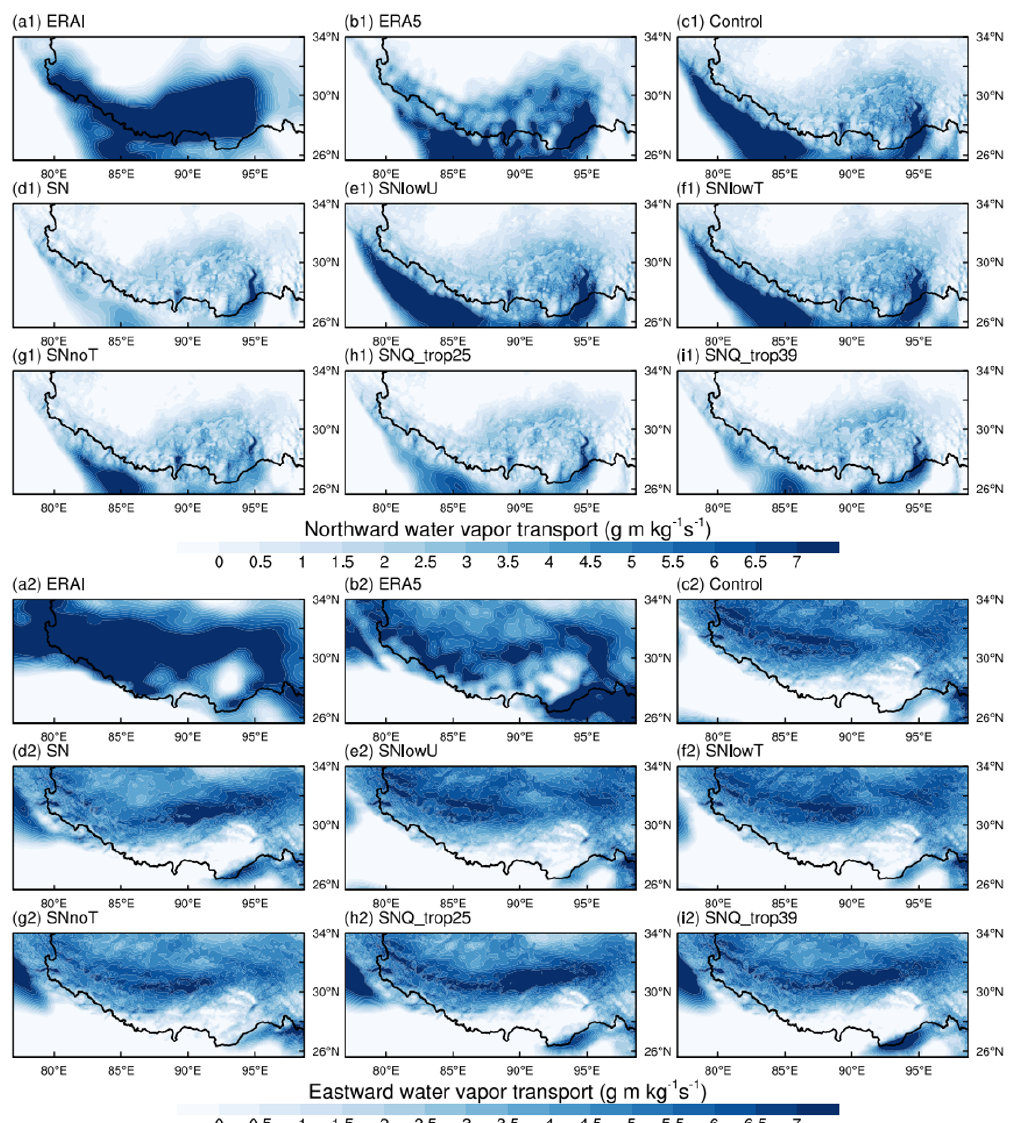
Figure 6. Column-integrated northward water vapor transport (meridional wind component multiples by specific humidity; gmkg − 1 s − 1 ) averaged over the study period over the central Himalayas derived from (a1) ERAI (ERA-Interim), (b1) ERA5, (c1) control, (d1) SN, (e1) SNlowU, (f1) SNlowT, (g1) SNnoT, (h1) SNQ_trop25, and (i1) SNQ_trop39. Panels (a2) – (i2) are the same as (a1) – (i1) but for the eastward water vapor transport (zonal wind component multiples by specific humidity; gmkg − 1 s − 1